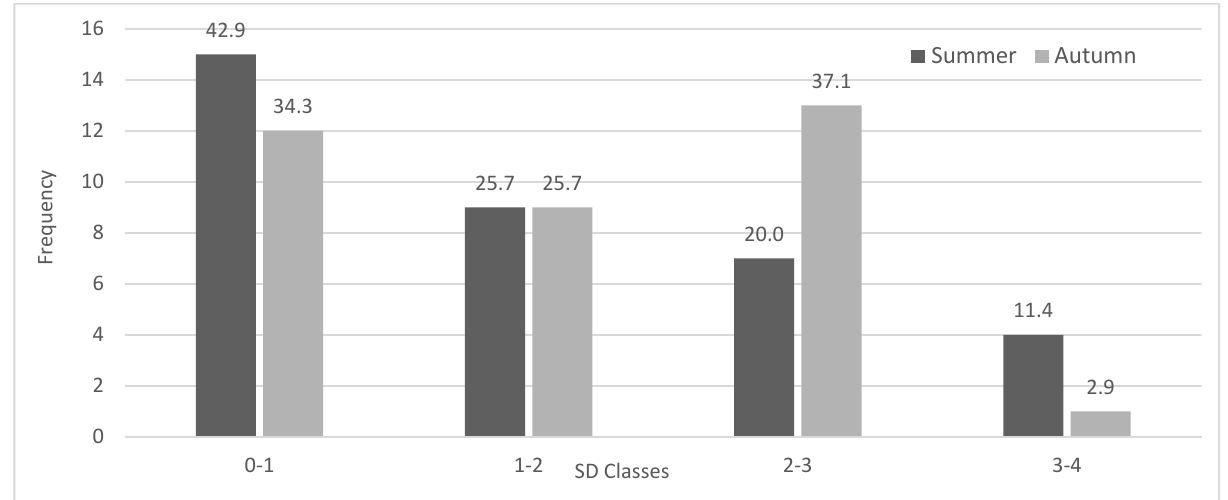
Figure 5. Classes of SD values of the loads measured in the two sampling seasons.